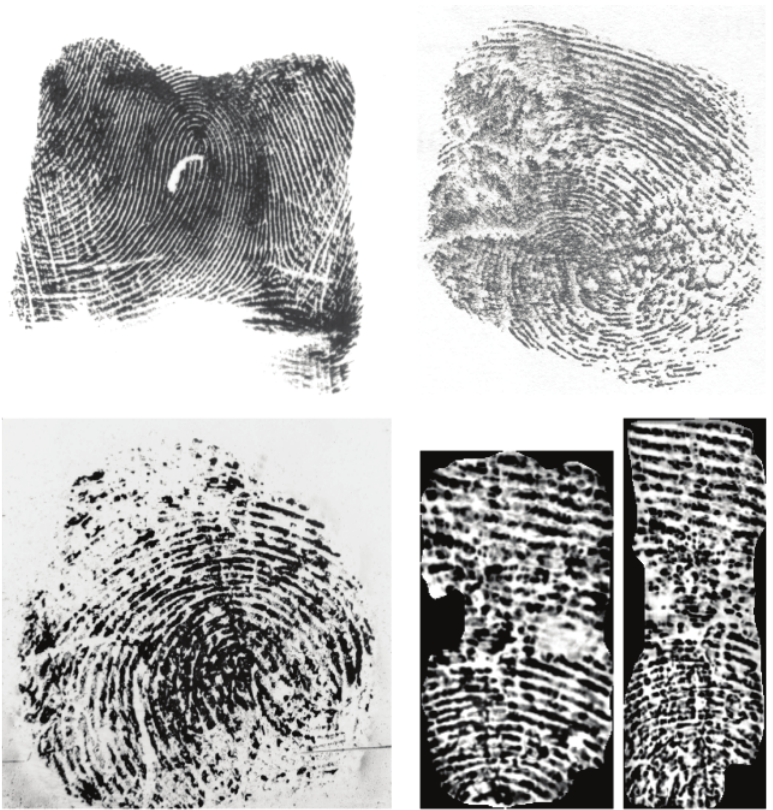
Figure 22: Fingerprints with atopic eczema (di ff erent